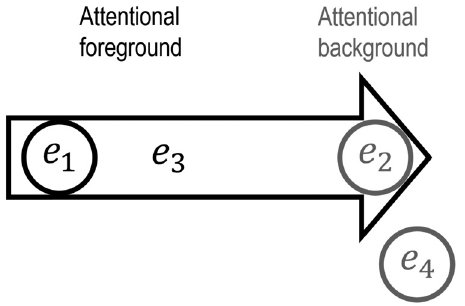
Figure 5: e 3 denotes the experienced ability to shift one ’ s focus of attention from P to Q. It is a fusion between e 1 ( which represents P ) and e 2 ( which represents Q ) . Hence, it constitutes an experienced connection. e 4 is an experience in the attentional background that is not connected to other experiences the subject currently has ( at least not via attentional agency )